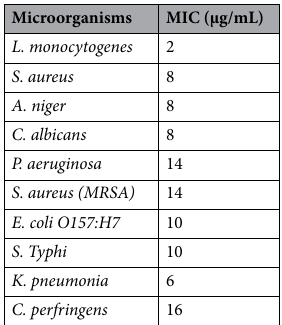
Table 1. MIC values of recombinant buforin I against some pathogenic bacterial and fungal strains. MIC, Minimum Inhibitory Concentration.